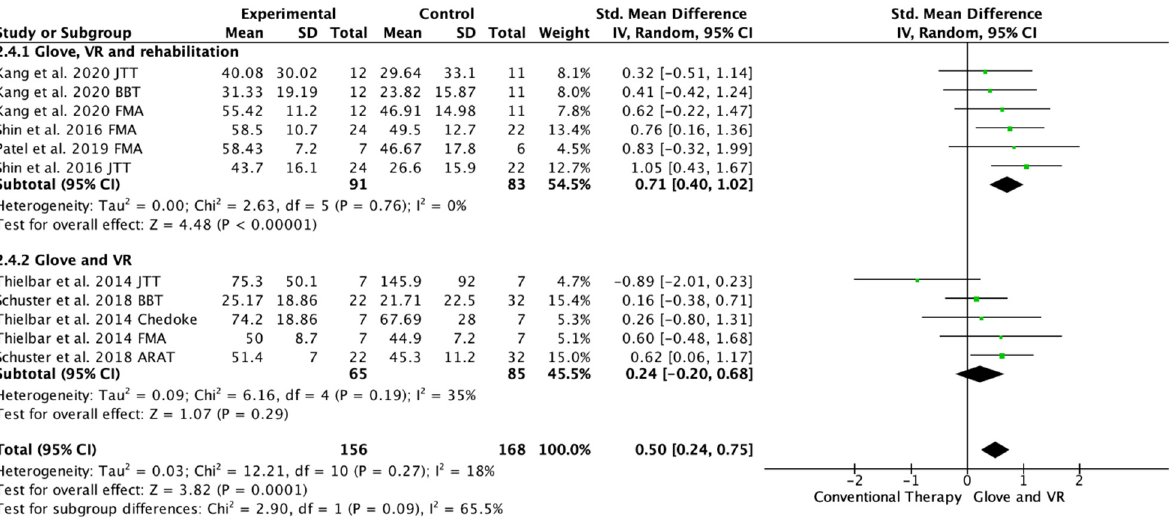
Figure 5. Forest plot of the results of a random-effects meta-analysis shown as standardized mean differences (SMD) with 95% confidence interval (CI) for long-term upper limb function assessment. Rehabilitation glove, combined with virtual reality and rehabilitation, and only rehabilitation glove, combined with virtual reality subgroups are reflected. The shaded square represents the point estimate for each individual study and the weight of the study in the meta-analysis. The diamond represents the overall mean difference of the studies [18,21–24].